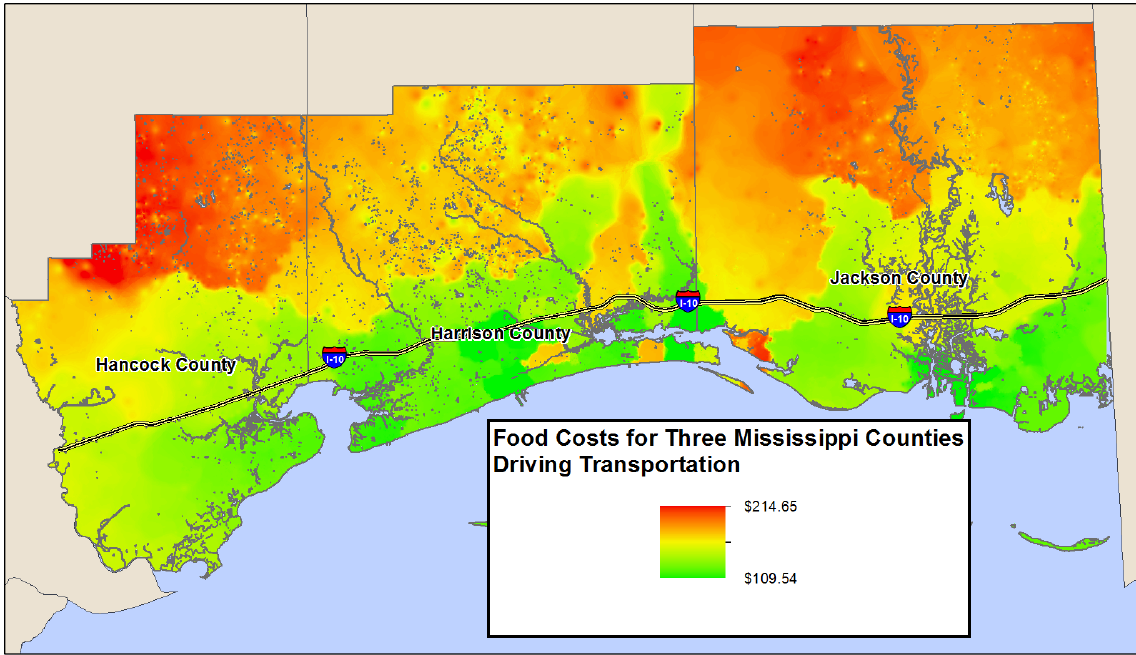
Figure 4. Map of the minimum total cost of the USDA Thrifty Food Plan in the Gulf Coast counties of Mississippi, during spring 2011, including both the costs of the food items and transportation by automobile to acquire them.